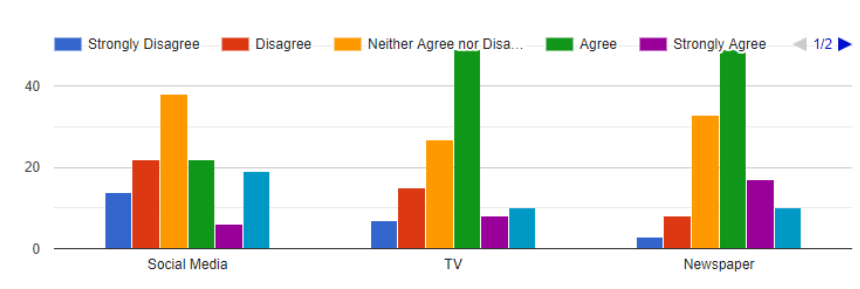
Graph 3: Promotion of the Scientific Approach (Source: Authors‟ depiction)